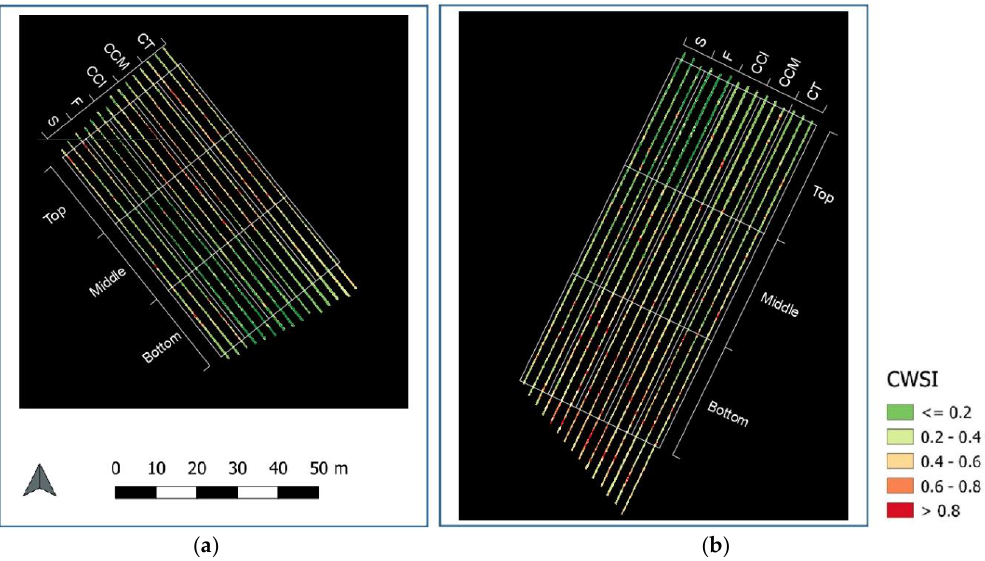
Figure 11. Maps of CWSI computed for ( a ) Montevertine and ( b ) San Giusto a Rentennano. The relationship between CWSI vs MSWP is shown in Figure 12a,b. The size of the bubble is proportional to the slope gradient, whereas the value next to the bubble indicates the NDVI value.